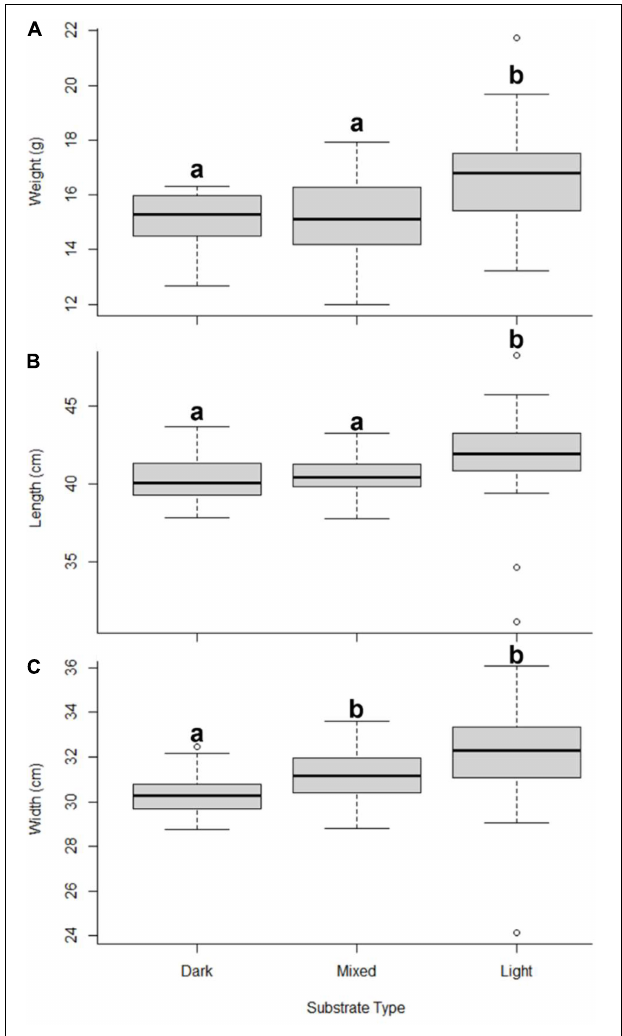
FIGURE 3 | Hatchling phenotype (A) weight, (B) straight carapace length, and (C) straight carapace width in the different incubation substrates (dark, mixed, and light) under controlled conditions in the hatchery. Different lowercase letters indicate statistically significant differences among treatments. The median is the bold line as a measure of central tendency, quartiles one (Q1) and three (Q3) marked by upper and lower box limits and maximum (max) and minimum (min) values marked with whiskers above and